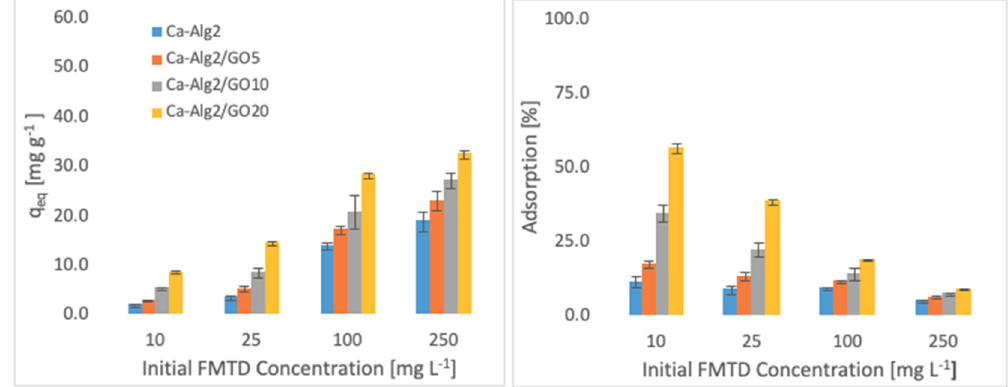
Figure 4. Effect of the initial MB concentration on q eq and adsorption percentage.